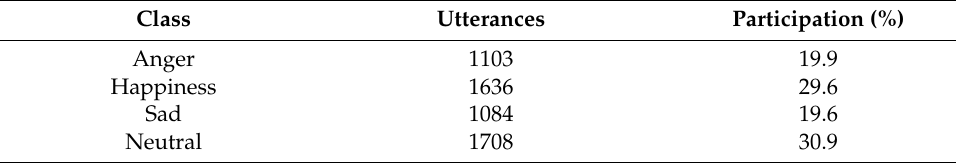
Table 1. The distribution of different emotions in the dataset